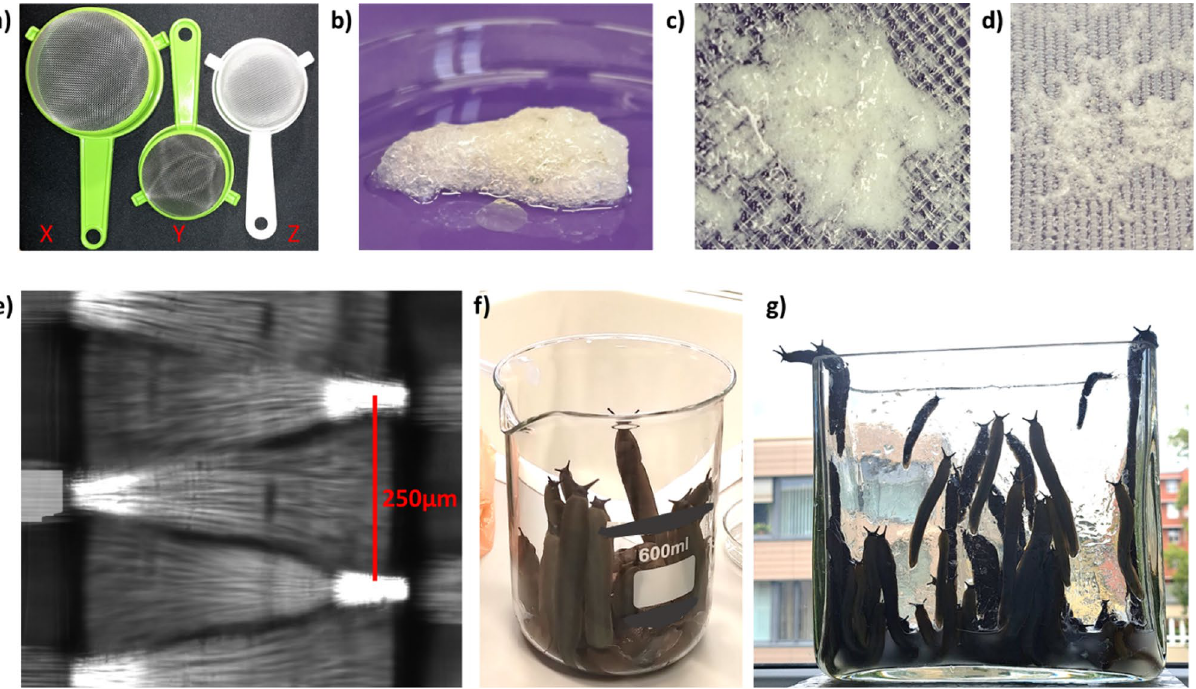
Figure 5. Mucus collection procedure. ( a ) Commonly available kitchen sieves with decreasing mesh size (X = 1 × 1 mm, Y = 0.75 × 0,75 mm, Z = tightly woven filaments) were used to filter the stiff and insoluble fraction of the mucus. ( b ) Fraction of the mucus left after filtration with X; Y = ( c ); Z = ( d ). ( e ) Detail of the Z’s mesh filaments under microscope (however, any sieve with mesh size of 0.5 × 0.5 mm down to 0.2 × 0.2 mm could be used as effectively). ( f , g ) After incubation of the slugs in the PBS buffer the slugs spontaneously crawl out of the containers to be collected, rinsed gently with tap water, and left to 200-mesh formvar/carbon grids (Merck) were placed on top of the drops and incubated for 30 min. Grids were then transferred on drops (100 µl) of PB for 1 min and then on drops (20 µl) of 1% glutaraldehyde (GA) in PB for 5 min. Grids were washed on drops (100 µl) of deionized water 8 times for 2 min. Finally, samples were stained on the drops (100 µl) of UranyLess stain for 3–5 min. The rest of UranyLess on the TEM grids was blotted with filter paper and grids were left to air dry for 1 h. Samples were observed in contrast mode with the accelerated voltage set to 100 kV and the beam current to 10 µA. Captured images were processed by the bitmap graphics software Gimp. Exosomal protein quantification was performed using the BCA protein assay Kit (Merck) and CBQCA pro- tein quantitation assay kit (Thermo Fisher Scientific). For the BCA assay 25 μl of each sample were mixed with 200 μl of working reagent, followed by heating at 37 °C for 30 min. EXs lysates were analysed, using 20 μl of each sample, 5 μl of RIPA 5× and 200 μl of working reagent and heated at 37 °C for 30 min. All samples were prepared in triplicates. A standard curve (0–2000 μg/ml) was prepared from six serial dilution points of bovine serum albumin (BSA) and working reagent, heated at 37 °C for 30 min. The CBQCA protein quantitation assay was performed according to the manufacturer protocol while using 1× PBS instead of the 0.1 M sodium borate buffer. The absorbance (at 562 nm for BCA assay) and fluorescence (excitation 465 nm, emission 550 nm for CBQCA assay) were measured in 96-well microplates (Thermo Fisher Scientific) using the GloMax Discover Microplate Reader (Promega). The data were analysed by GraphPad Prism (GraphPad Software). For the exosomal RNA isolation, the exoRNeasy Midi Kit (Qiagen) was used. 500 µl of isolated EXs in PBS were mixed with 1 ml of lysate buffer and processed according to the manufacturer’s protocol. The isolated RNA was mixed with 2× RNA Gel Loading Dye (Life Technologies) and analysed by gel electrophoresis using duplex with dTdT overhang (Sigma-Aldrich) was used as a loading control. Concentration was measured by a spectrophotometer DS-11 FX (DeNovix). The data were analysed by GraphPad Prism (GraphPad Software). Western blotting was used to verify the presence of exosome markers (adhesion proteins) in the slug EXs. A lysis buffer composed of RIPA 1X, mercaptoethanol 5% and 5 mM PMSF was used to lysate exosome samples. Samples were incubated with lysis buffer for 30 min at 4 °C, followed by subjection to the SDS-PAGE on a 12% polyacrylamide gel. Proteins were blotted onto the nitrocellulose membrane. 5% milk in TBST was used as a blocking agent and for antibody dilution. The membrane was incubated with the primary antibody (diluted 500× in 5% milk in TBST) overnight at 4 °C. Subsequently, the membrane was washed six times in TBST and incubated with the secondary antibody at room temperature for 1 h. Washed membrane was incubated in Super- Signal West Femto Maximum Sensitivity Substrate (Thermo Fisher Scientific) and visualised. Primary antibodies